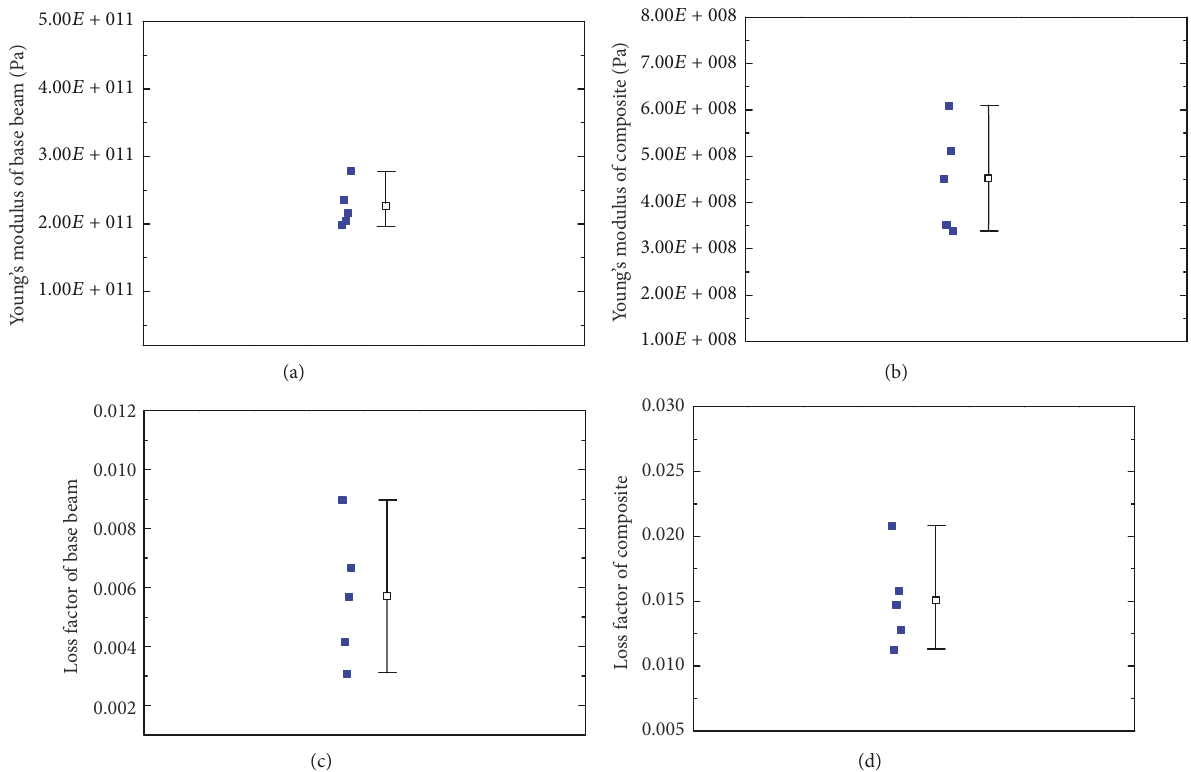
Figure 6: Identified material properties from experimental test (the five data dots in a group represent Young’s modulus and loss factor identified with the first five natural frequencies measured from experiment. The bar on the right side of data dots denotes the maximum, minimum, and mean of the five data dots).